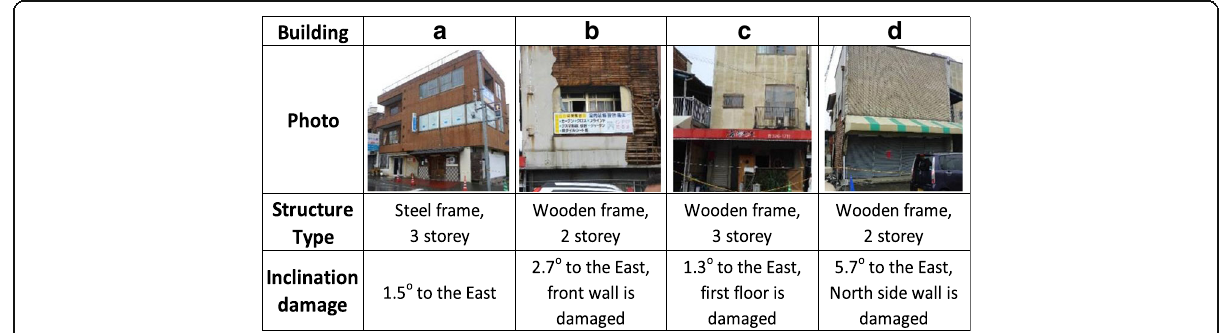
Fig. 18 The summary of the structure type and damage level (Buildings A, B, C and D in Fig. 17) in